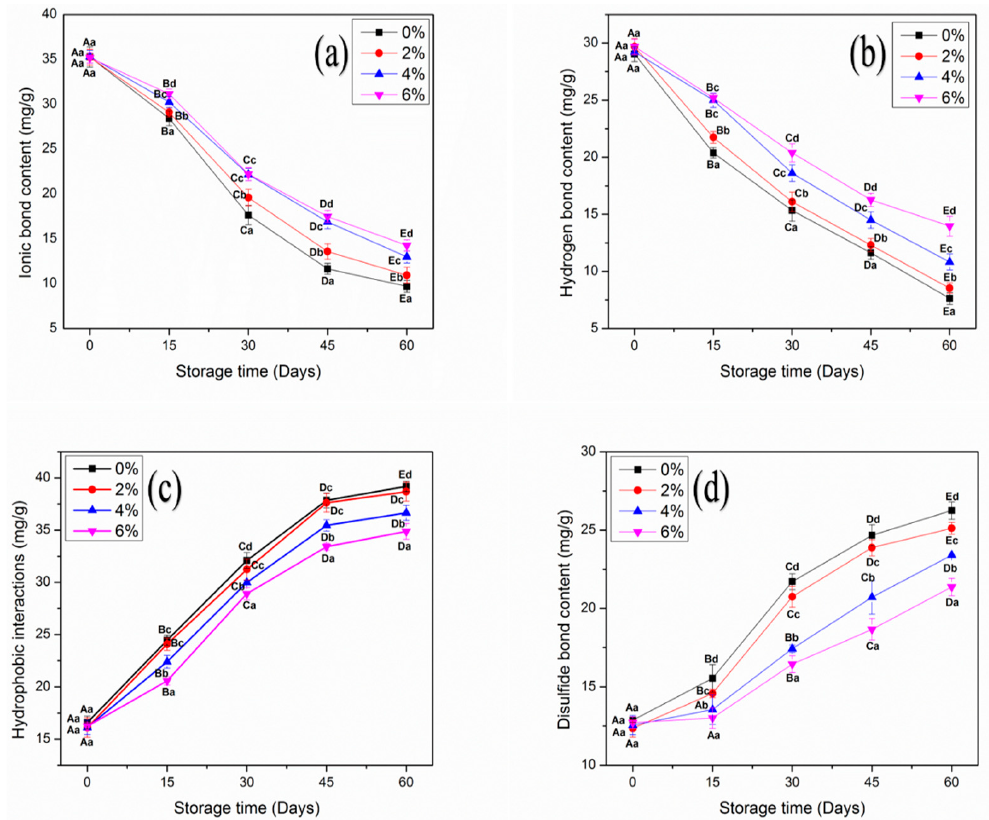
Figure 6. The content of ionic bond ( a ), hydrogen bond ( b ), hydrophobic interaction ( c ), and disulfide bond ( d ) of myofibrillar protein treated with different concentrations of OVA-KC during 60 days of frozen storage at − 18 ◦ C. Capital letters ( A – E ) refer to the significant differences in similar treatments within the different storage times ( p < 0.05). Lowercase letters ( a – d ) refers to the significant difference in the same frozen storage period of different concentrations ( p < 0.05).